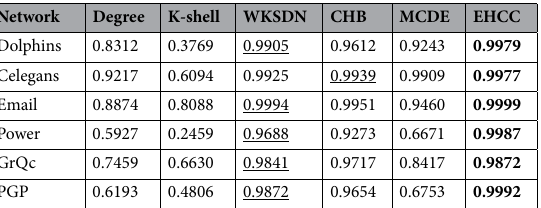
Table 7. Monotonicity scores of different algorithms in six real networks. The highest and second highest values in each network are highlighted in bold and underlined,